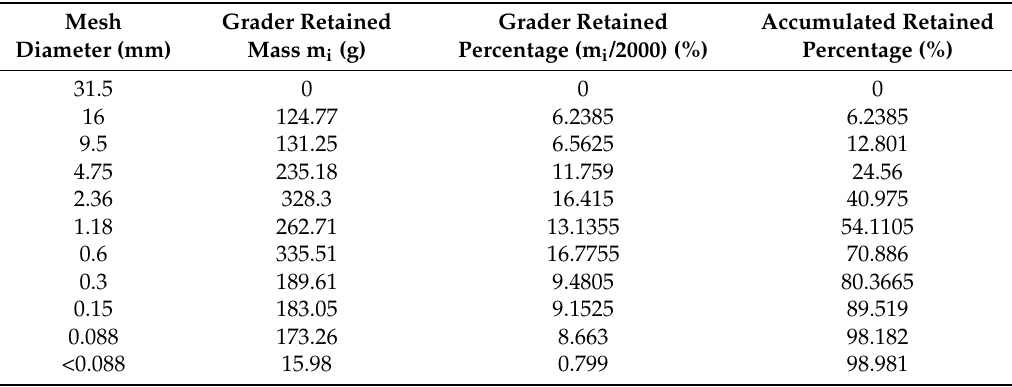
Table 1. Initial sample screening experiment